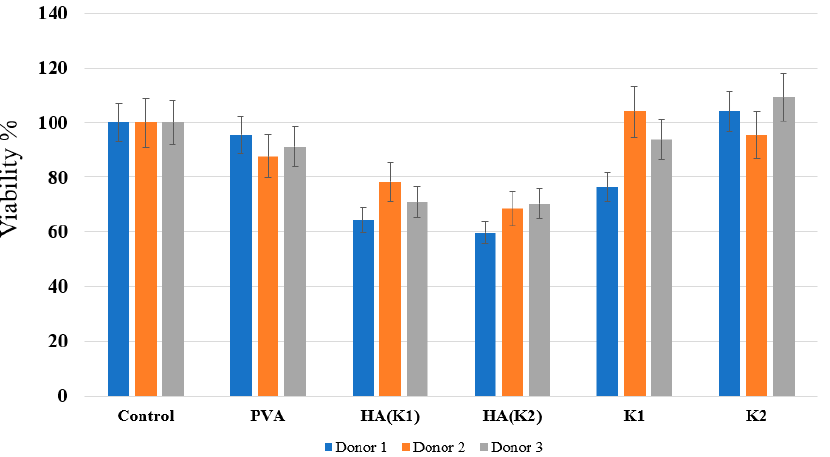
Figure 5. Study of the viability of macrophages in the presence of composite materials K1 and K2, pure hydroxyapatite HA(K1) and HA (K2), and pure PVA on three